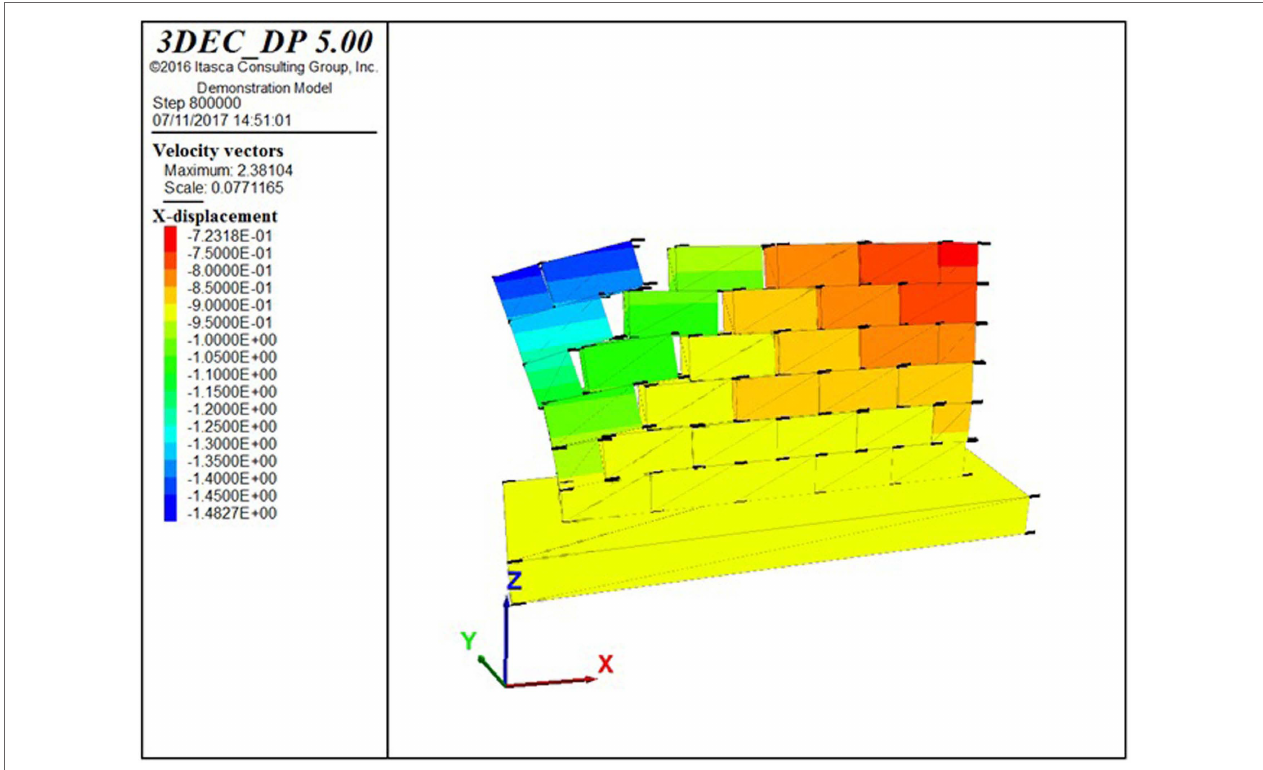
FIGURE 11 | Collapse mechanism for model I2 (activation acceleration =